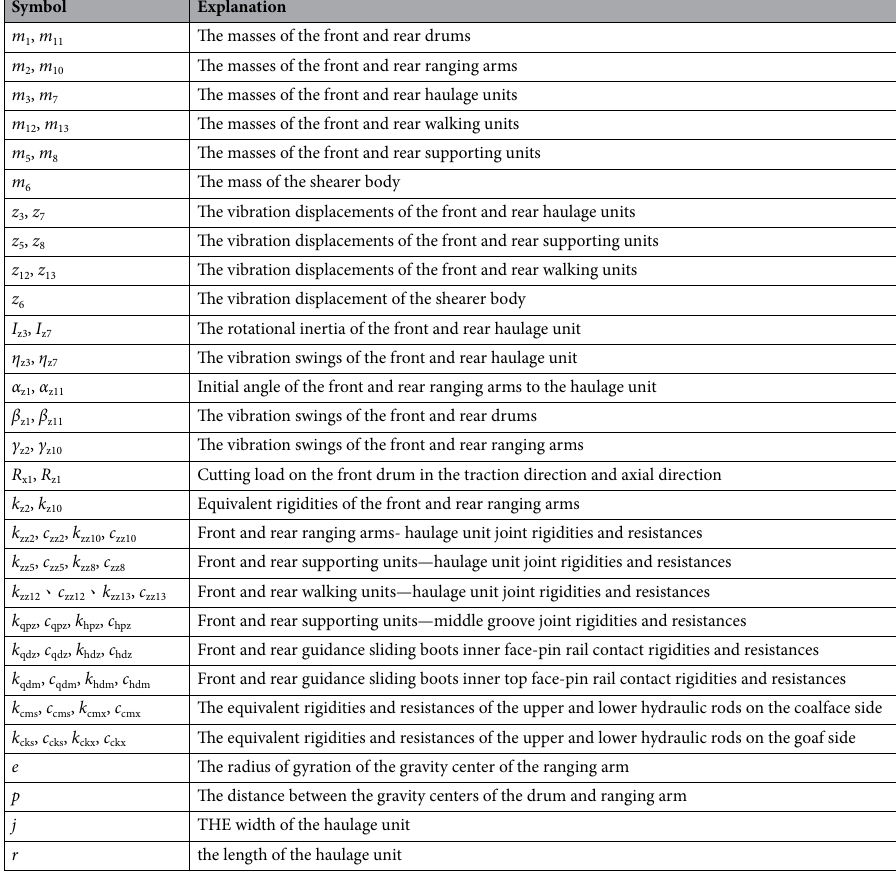
Table 1. Description of symbols in Fig.